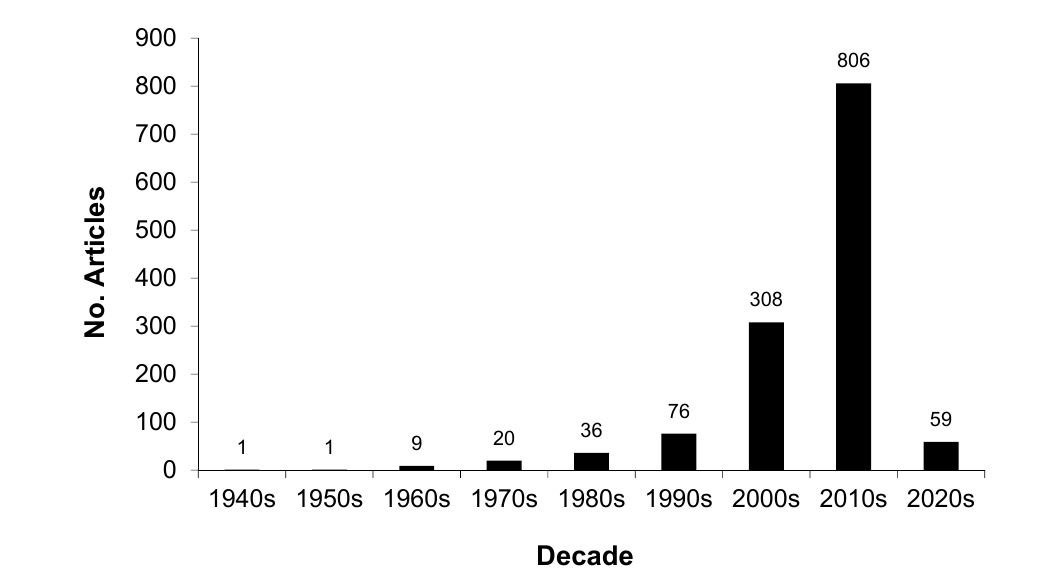
Figure 4. Number of articles dealing with irrigation and vineyard produced by a search in the Web of Science database performed on 11 September 2020.